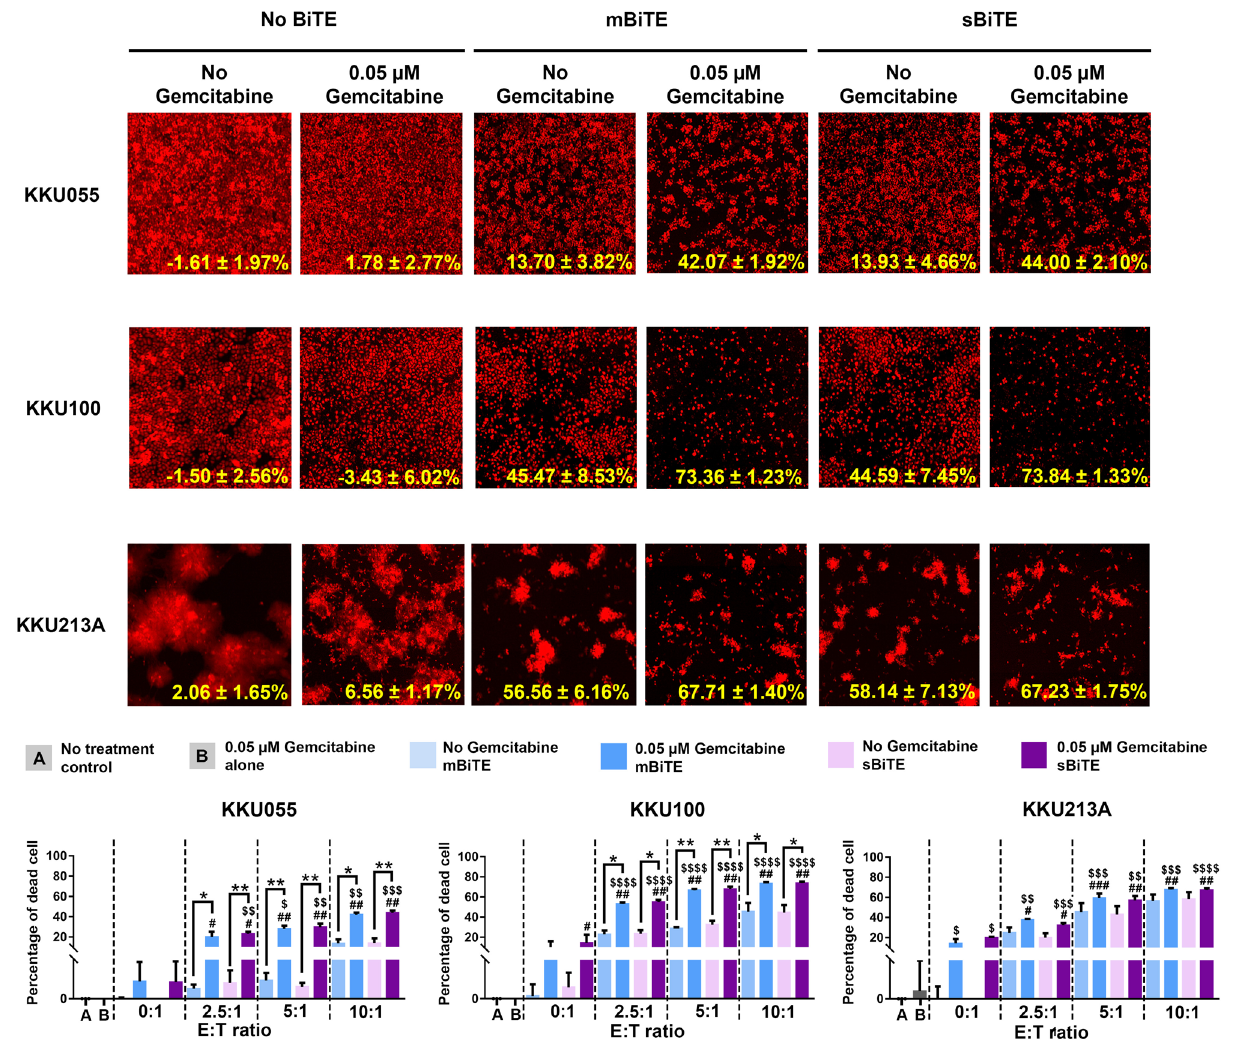
Figure 6. Combination gemcitabine and BiTE enhanced T cell killing ability against CCA cells. The remaining cells after 24-h co-culture of T cells in presence or absence of gemcitabine and/or BiTE were observed under the florescence microscope at an E:T ratio of 10:1 (top). The bar graph showed the percentage of cell death relative to non-treatment control at E:T ratios of 0:1, 2.5:1, 5:1, and 10:1 (bottom). Data are presented as the mean ± standard error of the mean (SEM) (error bar). The statistical differences of cell death after T cell co-culturing in combination condition comparing to BiTE treatment without gemcitabine were designated as * (* p < 0.05; ** p < 0.01; *** p < 0.001), comparing to gemcitabine treatment alone were designated as # ( # p < 0.05; ## p < 0.01; ### p < 0.001), comparing to BiTE treatment alone were designated as $ ( $ p < 0.05; $$ p < 0.01; $$$ p < 0.001, $$$$ p <